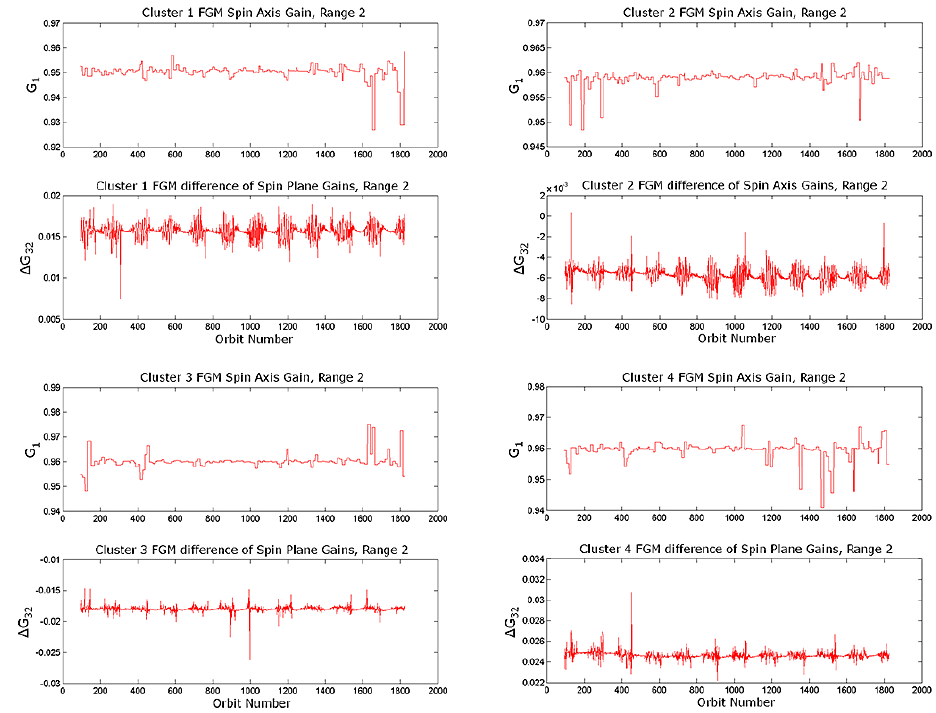
Figure 11. Gain plots ( G 1 and 1G 32 ) from February 2001 to February 2012 showing periodic behaviour of spin-plane gain difference for range 2 in all